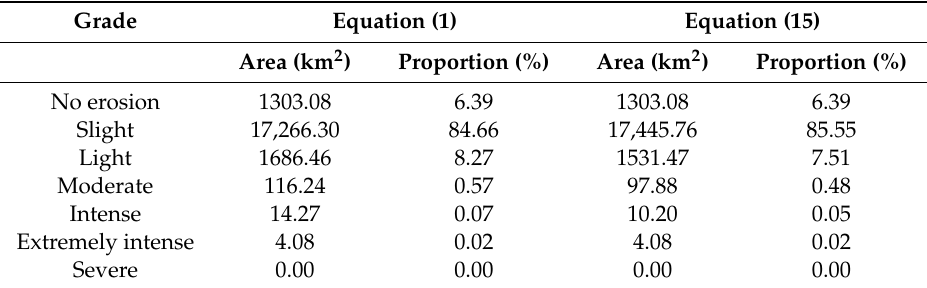
Table 5. Area for each soil erosion grade.